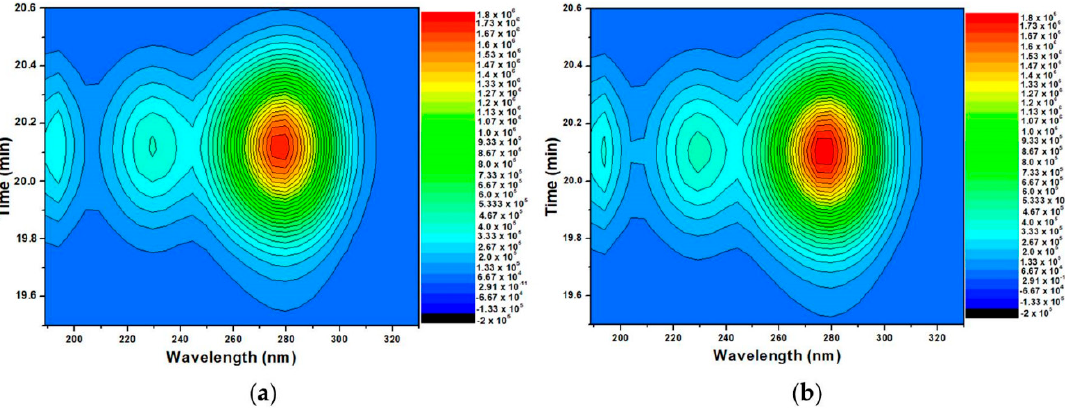
Figure 10. ( a ) Contour curves of the furfural pattern 0.5 (w/v%); ( b ) The analysis of the product obtained after the reaction with the catalyst 18%Nb-DB (180 °C). The X -axis represents the UV-Vis absorbance spectrum, and the Y -axis represents the retention time in the chromatogram.